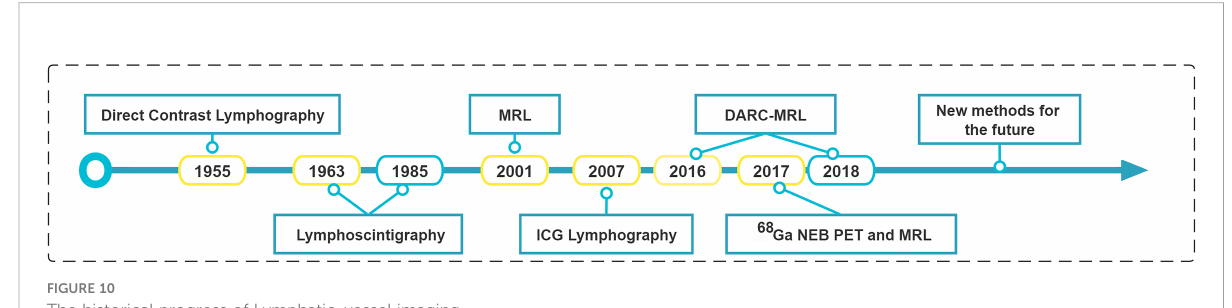
FIGURE 10 The historical progress of Lymphatic-vessel